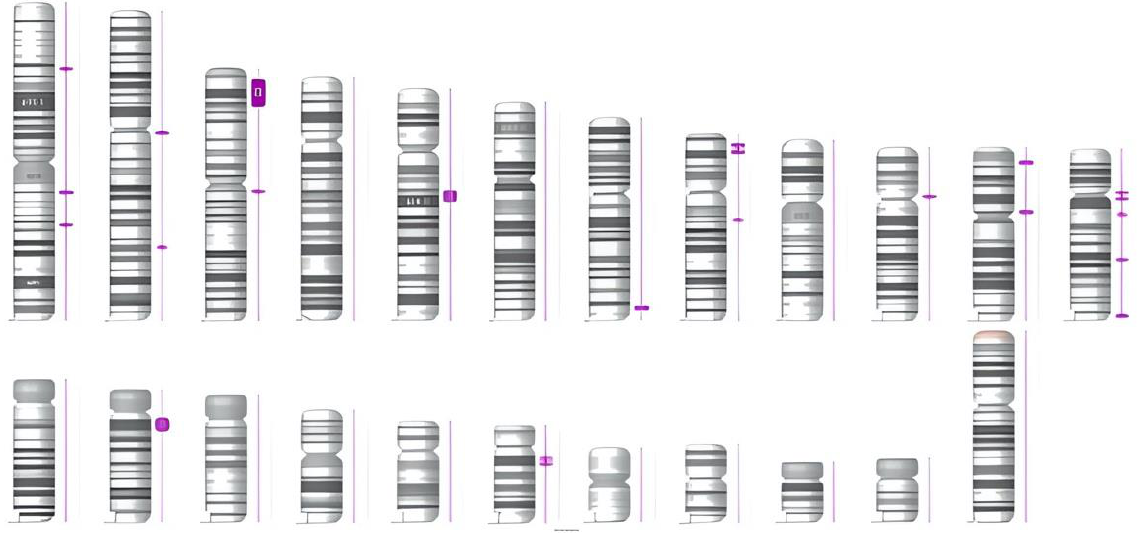
Figure 5. Loss of heterozygosity regions identified with SNP array.